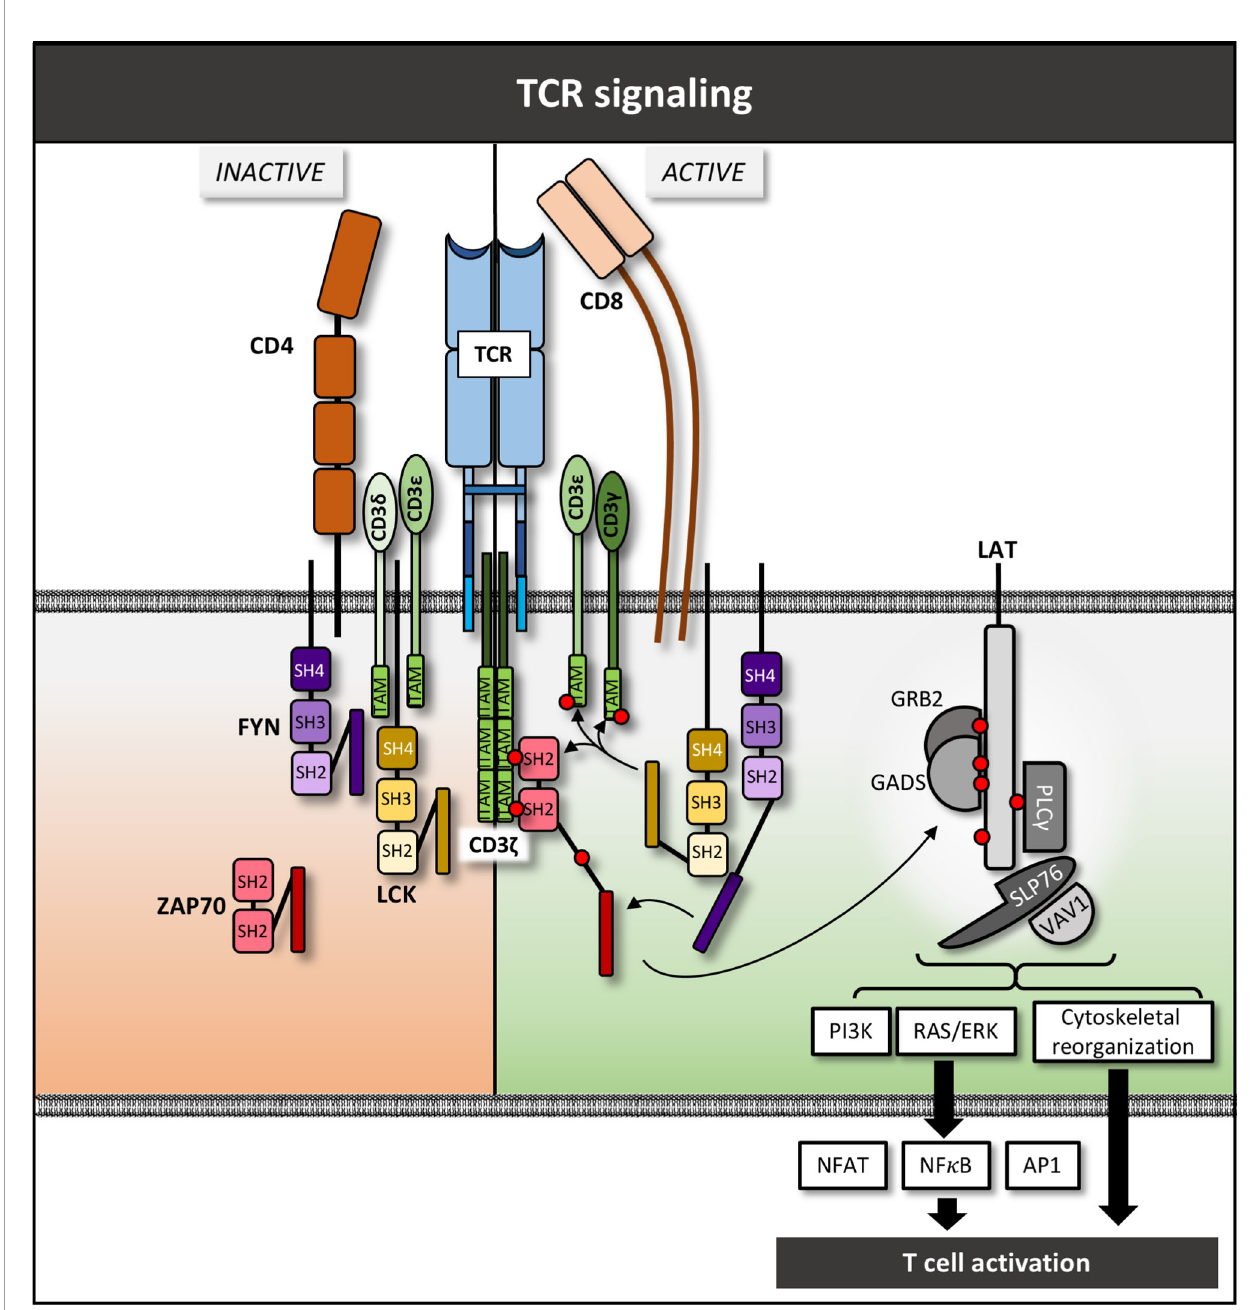
FIGURE 1 | TCR complex and downstream signaling pathway – schematic overview. Red circles denote phosphate